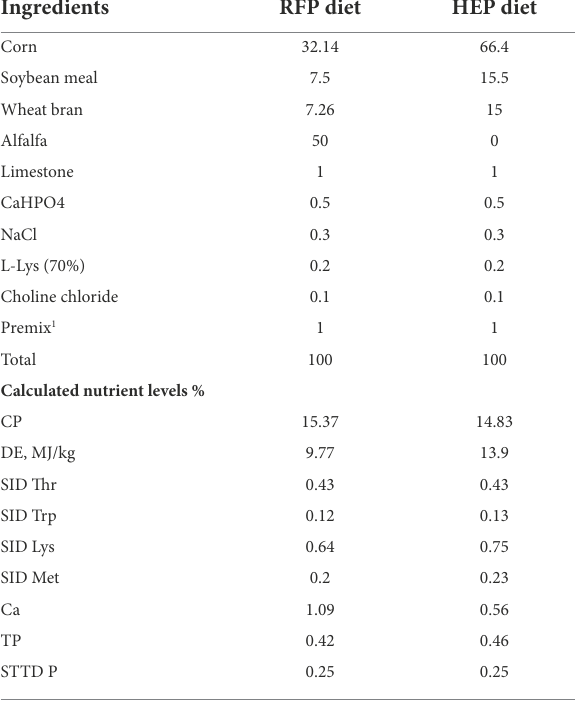
TABLE 1 Composition and nutrient level of experimental diet (as fed- basis).